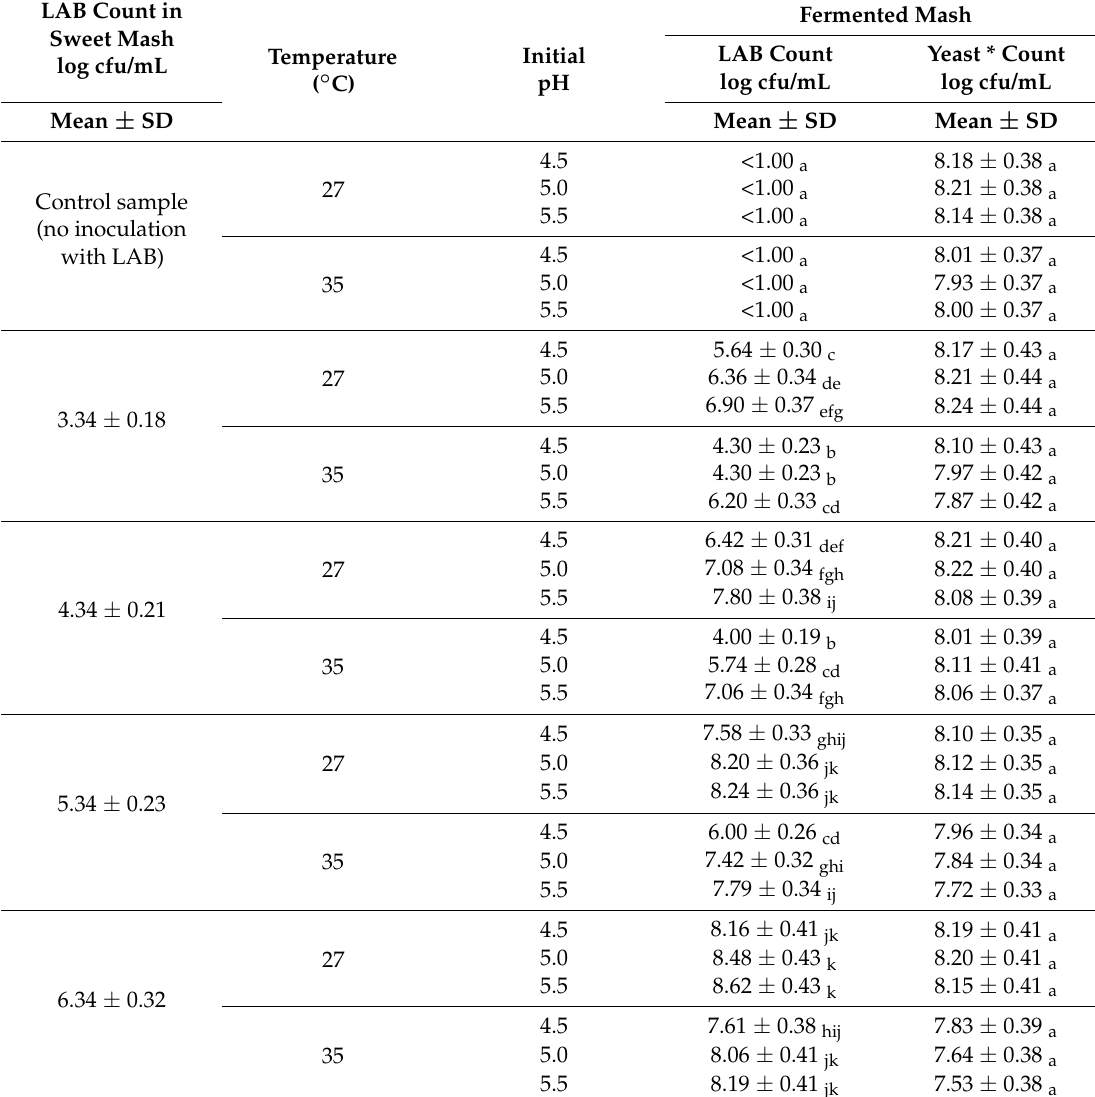
Table 1. Microbial analysis of fermented